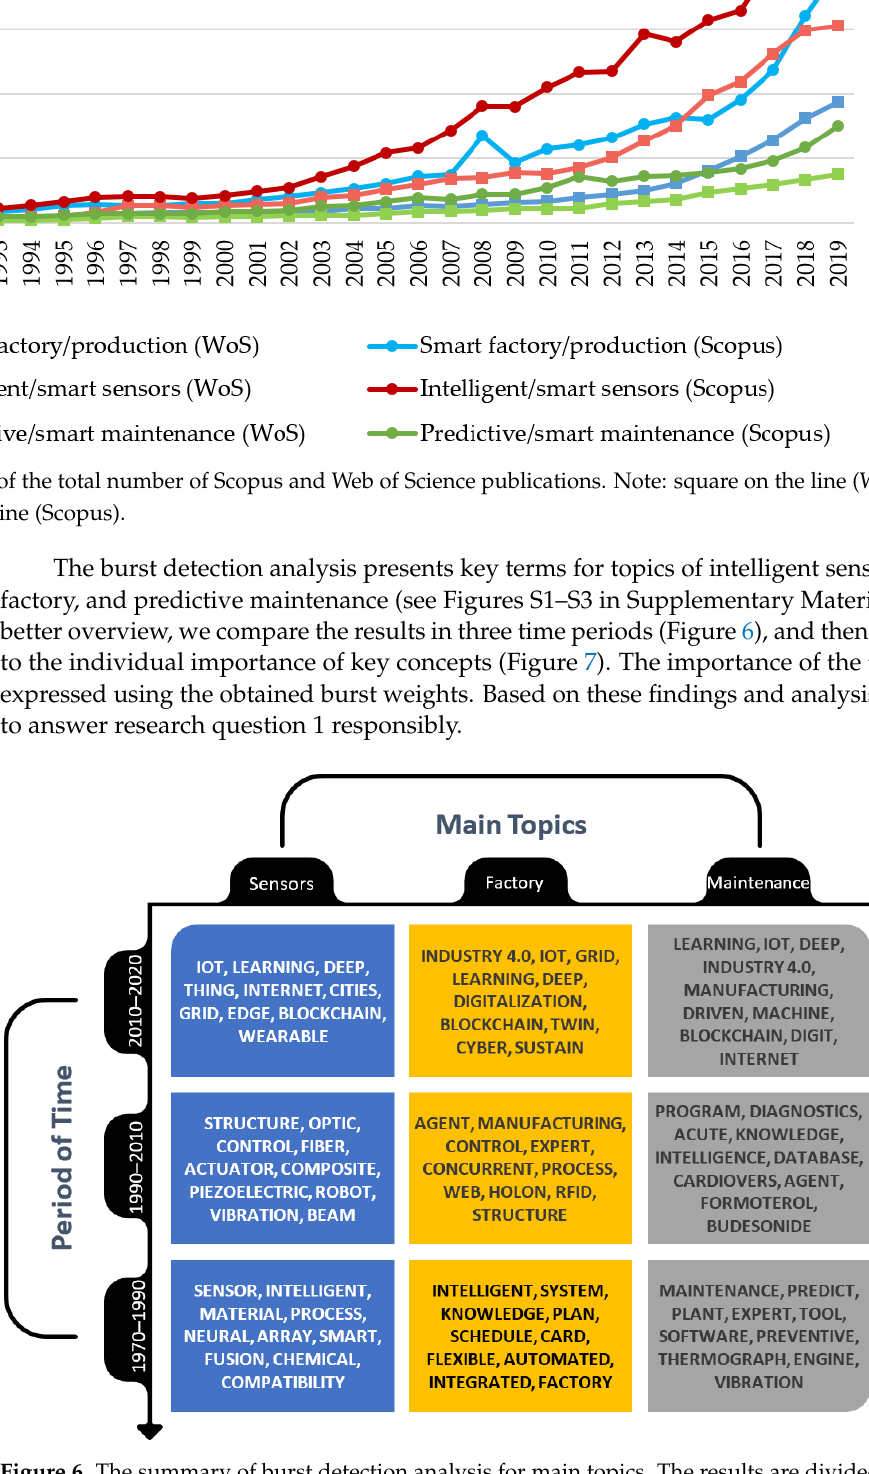
Figure 6. The summary of burst detection analysis for main topics. The results are divided into three periods of time (1970– 1990, 1990–2010, and 2010–2020). The terms in each period are sorted according to the burst weights. Top cited papers from smart factory/production areas focus on using ion batteries for smart grids [59,60] and nanomaterials’ intelligent design [61]. The results show that the